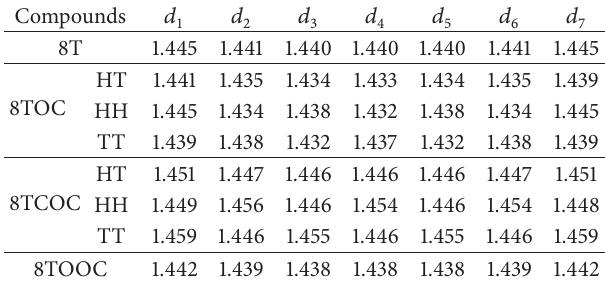
Table 1: Values of interring bond lengths 𝑑 𝑖 (˚A) of the studied compounds obtained by B3LYP/6-31G(d,p) level.